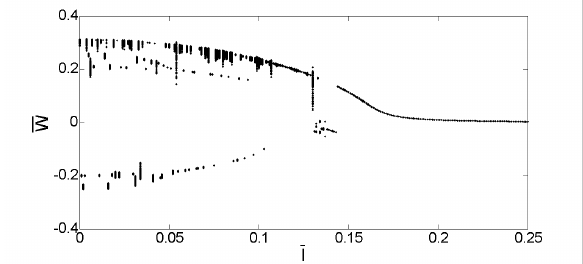
Fig. 5: Bifurcation diagram of the deflection with variation of mate- rial length scale parameter.